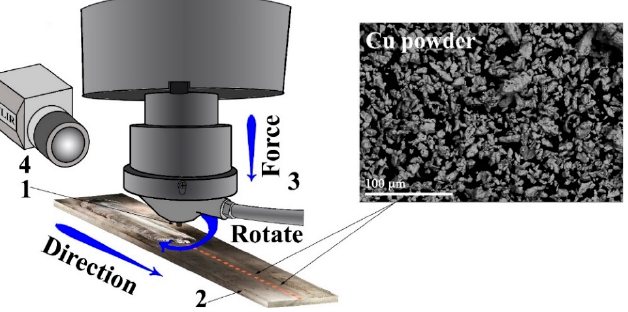
Figure 1. Schematic diagram of friction stir processing (FSP) on Ti6Al4V. 1—pin; 2—Ti6Al4V sheet; 3—cooling system; 4—IR camera FLIR SC655.